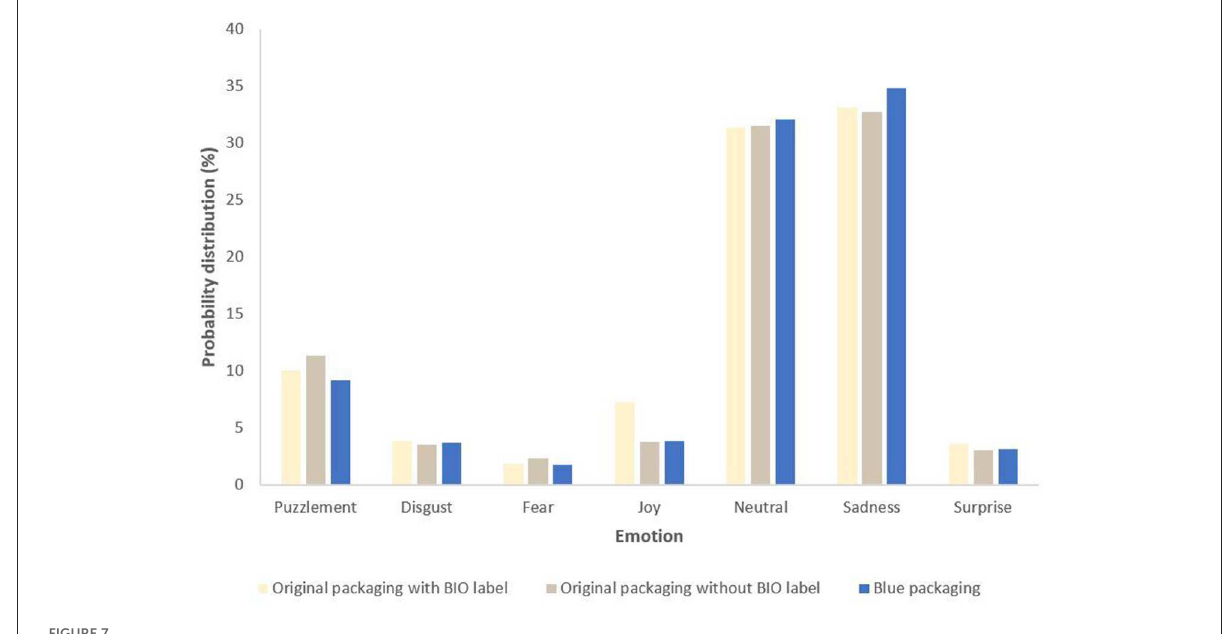
FIGURE7 Probability of elicited emotion when looking at Passata.